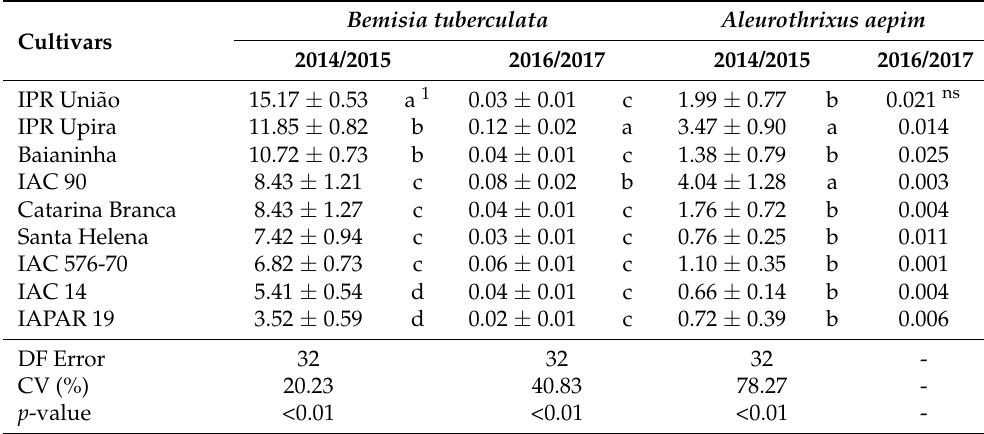
Table 1. Nymph density (median ± standard deviation) of Bemisia tuberculata and Aleurothrixus aepim per leaf on the plant’s superior third portion, from nine cassava cultivars, Londrina, Paran á , crop season 2014/15 and